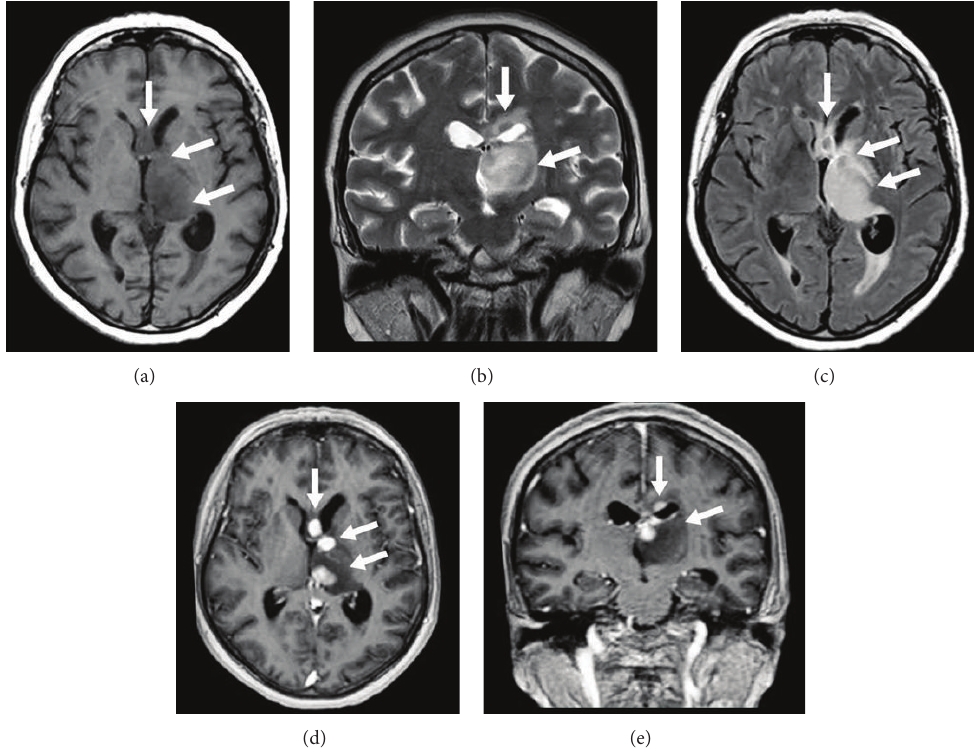
Figure 19: A patient with primary CNS lymphoma involving the left-sided thalamus, the internal capsule, and the anterior part of the corpus callosum seen as hypointensity on axial unenhanced T1-weighted imaging (a), hyperintensity on coronal T2-weighted (b) and axial FLAIR (c) imaging, with multifocal enhancement on axial (d) and coronal (e) gadolinium-enhanced T1-weighted imaging.